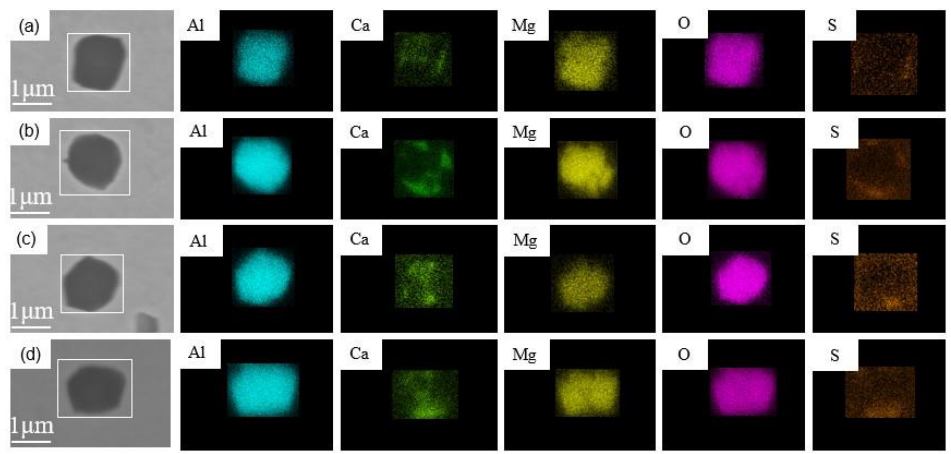
Figure 5. Part of inclusions at 30 s after Mg addition.